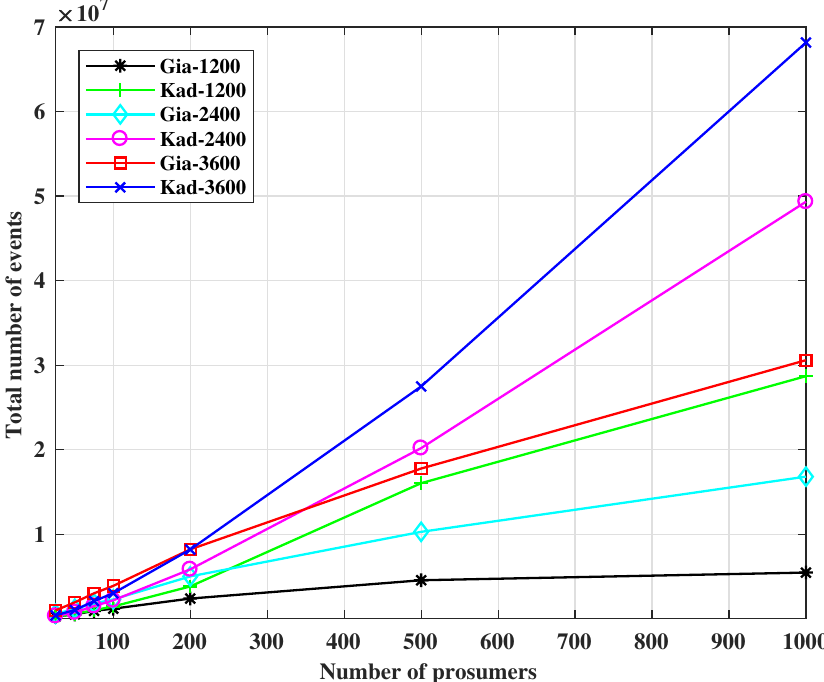
Figure 7. Number of events created as the activity period and number of prosumers